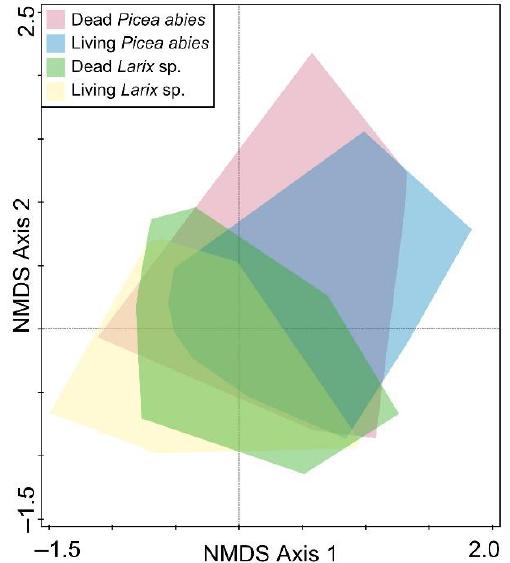
Figure 4. Ordination diagram based on nonmetric multidimensional scaling (NMDS) of lichen communities on dead and living trees of Picea abies and Larix sp . In NMDS, 44.2% variation was explained on axis 1, and 34.5% was explained on axis 2.